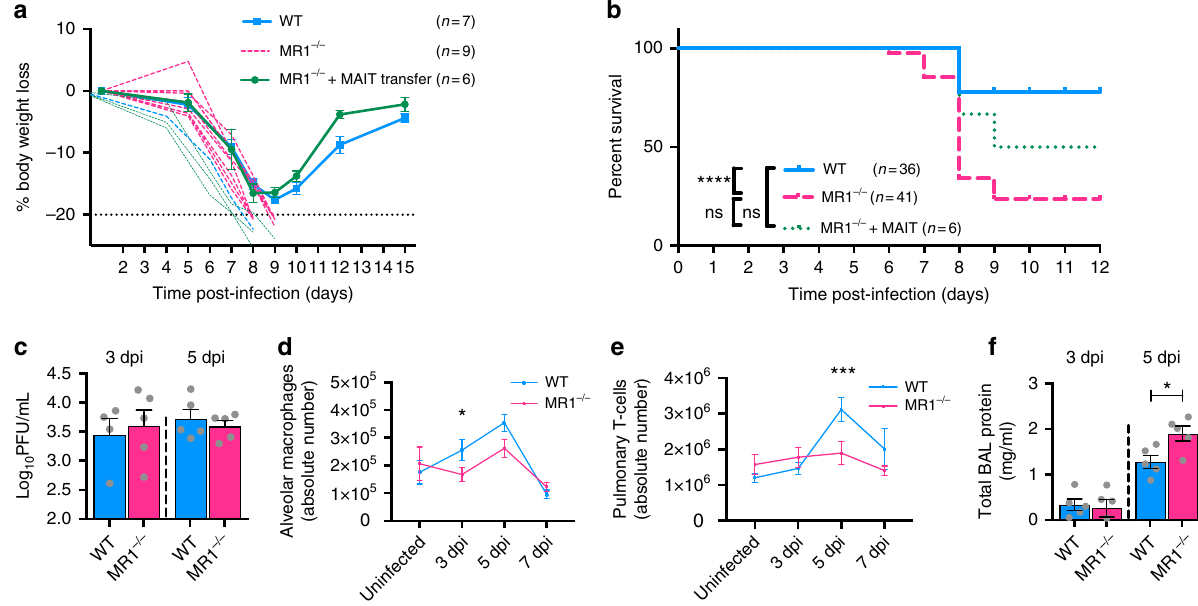
Fig. 3 MR1 − / − mice show enhanced weight loss and mortality in response to severe in fl uenza. a Body weight loss expressed as a percentage after infection with 100 PFU PR8 virus. WT ( n = 7) and MR1 − / − data ( n = 9) are representative of four experiments with similar results. Adoptive transfer ( n = 6), performed once, used 1 × 10 6 pulmonary MAIT cells from WT mice previously infected with 10 6 CFU S. Typhimurium BRD509 for 7 days to expand the MAIT cell population. Cells were transferred 1 week prior to in fl uenza virus infection. Graphs show mean weights ± SEM for surviving mice, with individual plots for animals which succumbed to infection. b Survival curves after intranasal infection with 100 PFU of PR8, showing combined data from one (MR1 − / − + MAIT cells, n = 6) to four experiments (WT, n = 36; MR1 − / − , n = 41). Survival curves compared using log-rank (Mantel – Cox) tests. c Titres of infectious virus in clari fi ed lung homogenates at 3 and 5 dpi, expressed as plaque-forming units (PFU). Data are from a single experiment. d Absolute numbers of alveolar macrophages and e MR1-5-OP-RU tetramer-negative T cells in single cell lung suspensions prepared from uninfected animals and from animals at 3, 5 and 7 dpi. Data are combined from three experiments with similar results. f Total protein concentration in cell-free BAL supernatants at days 3 and 5 post-infection. Graphs show means± SEM. *Mann – Whitney P < 0.05; *** P < 0.001